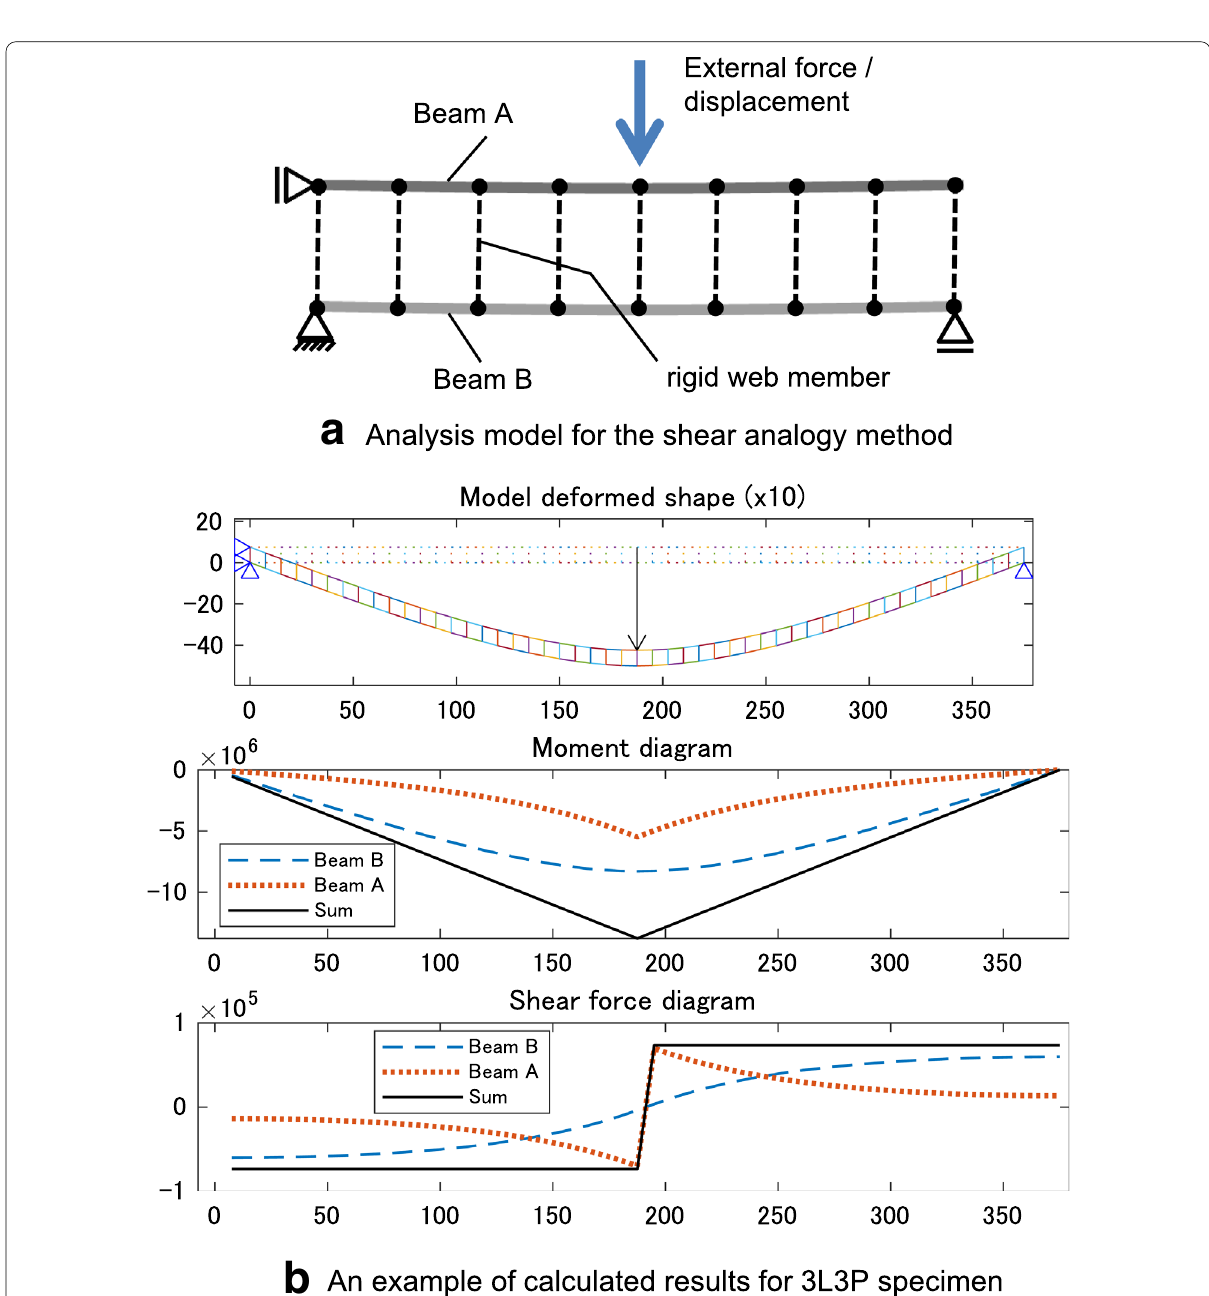
Fig. 8 Analysis model for the shear analogy method and example of results for 3L3P ( l ef / d